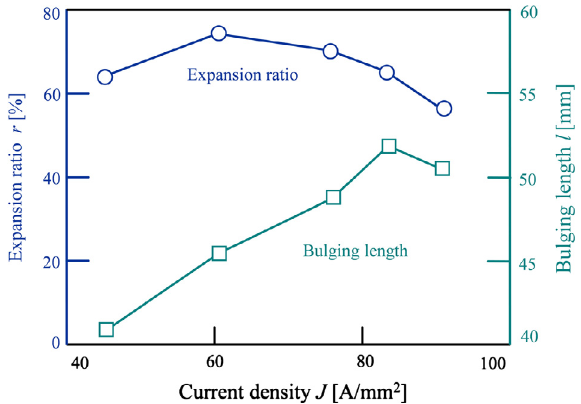
Figure 9. Relationships between expansion ratio and current density for p 0 = 0.8 MPa.